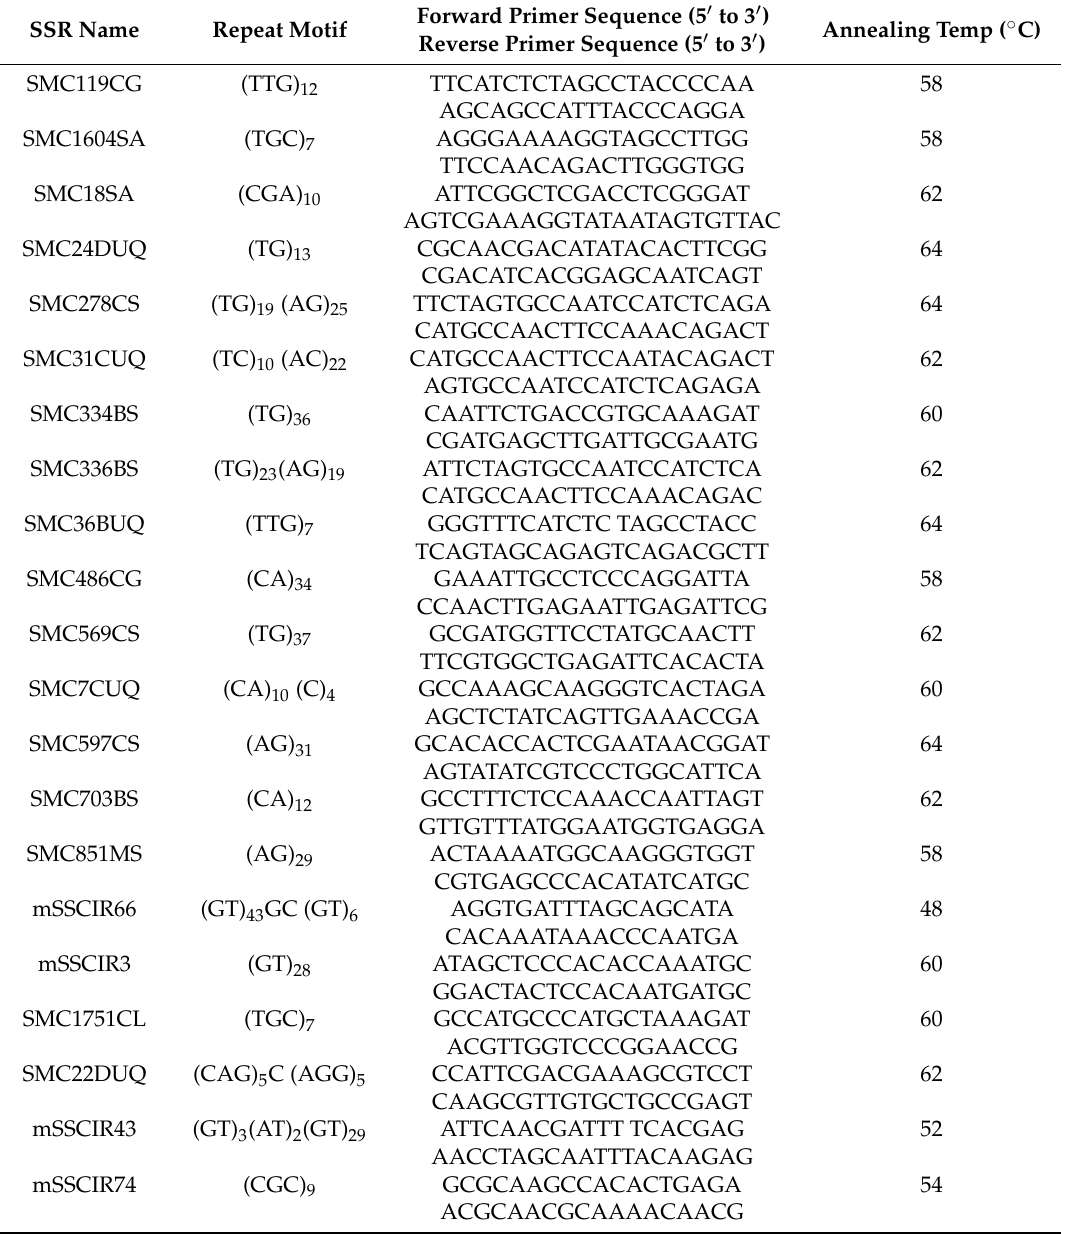
Table 1. Name, repeat motif, nucleotide sequence of forward and reverse primer, and annealing temperature of 21 sugarcane microsatellite